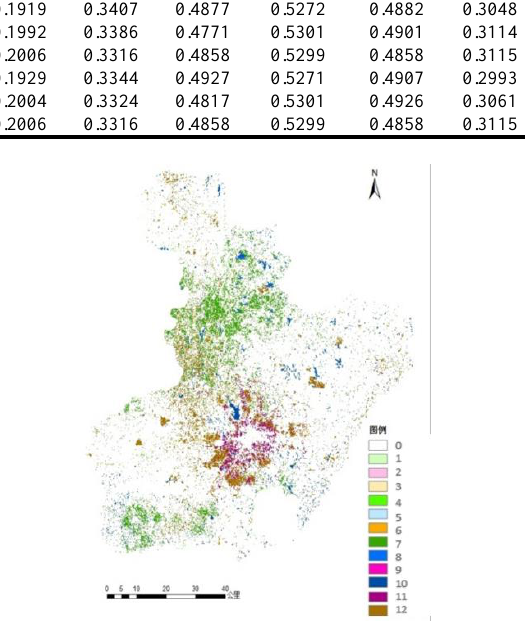
Figure 7 Multi-class change map of MCVA method from the